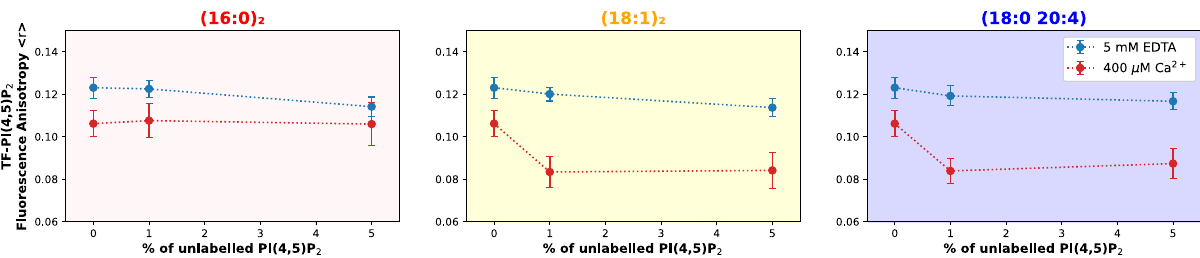
Fig. 1 Cation-induced clusters are formed independently of PI(4,5)P 2 acyl-chain composition as seen by homo-FRET of the TF-PI(4,5)P 2 analog. PI(4,5)P 2 cluster formation was determined through the incorporation of 0.1 mol% of TF-PI(4,5)P 2 in LUVs containing POPC and increasing concentrations of unlabeled PI(4,5)P 2 . The experiments were carried out for the three unlabeled PI(4,5)P 2 species, with different acyl-chain composition. TF-PI(4,5)P 2 fl uorescence anisotropy ( <r> ) values were measured in the presence (400 µ M Ca 2 + , red) and absence (5 mM EDTA, blue) of calcium. Error bars represent the SD from N = 3 independent experiments. A signi fi cant decrease in TF-PI(4,5)P 2 fl uorescence anisotropy in the presence of calcium is observed for the three PI(4,5)P 2 species ((16:0)2 PI(4,5)P 2 : F(1,12) = 17.87, p = 0.0012; (18:1) 2 PI(4,5)P 2 : F(1,12) = 96.84; p < 0.0001; (18:0 20:4) PI(4,5)P 2 : F(1,12) = 107.7, p